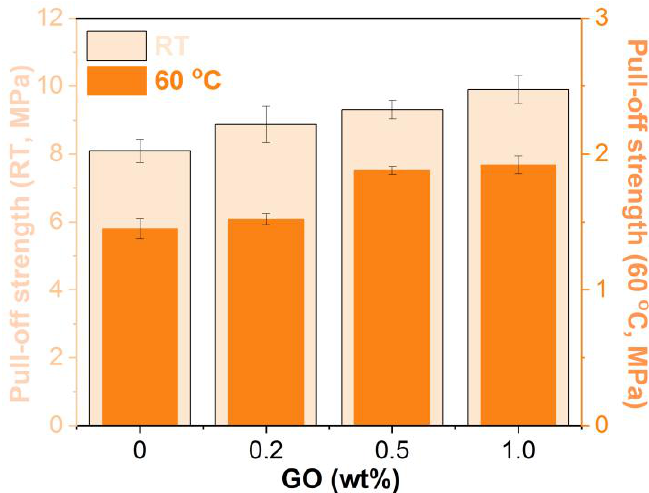
Figure 12. Pull-off strengths of the unmodified and GO-modified EABCs.